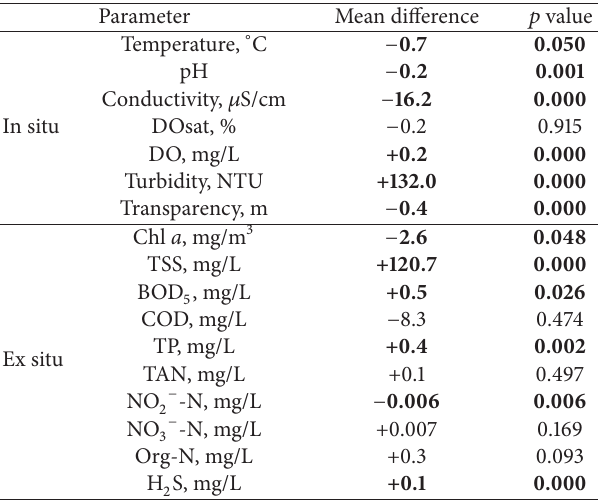
Figure 3: Ex situ water quality of (a) chl a , (b) TSS, (c), BOD 5 , (d) COD, (e) TP, (f) TAN, (g) NO 2− -N, (h) NO 3− -N, (i) Org-N, and (j) H 2 S measured at the 30 sampling stations located along the Batang Baram (left axis) and its tributaries (right axis) (different letters indicate significant difference at 𝑝 value ≤ 0.05). Table 3: Mean difference of in situ and ex situ water quality parameters between the main river of the Batang Baram and its tributaries.